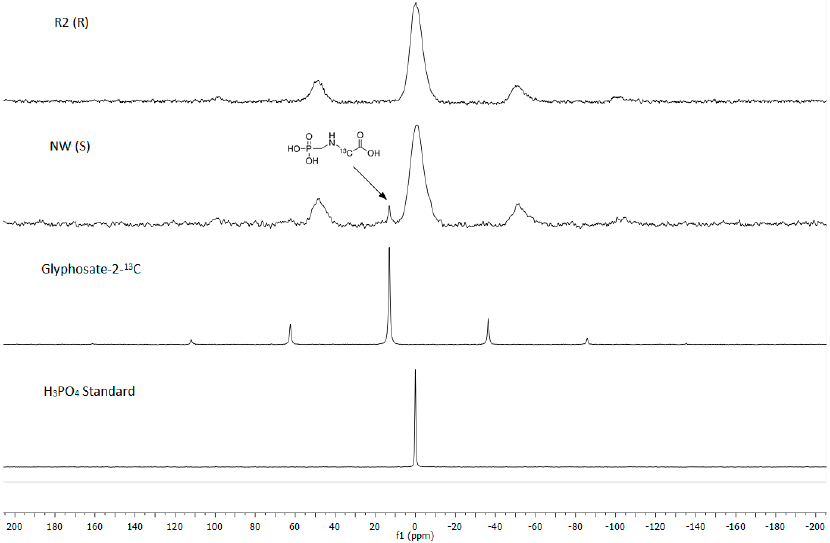
Figure 4. The 31 P NMR spectra obtained from untreated NW (S)/R2 (R) biotypes plantago ( Plantago lanceolata L.) dried leaf tissue, 48 h after glyphosate application on the treated leaves. Arrow indicates glyphosate signal approximately at 13 ppm identical to the glyphosate-2- 13 C (99% atom) standard’s chemical shift. All 31 P spectra are referenced against orthophosphoric acid set at 0 ppm.